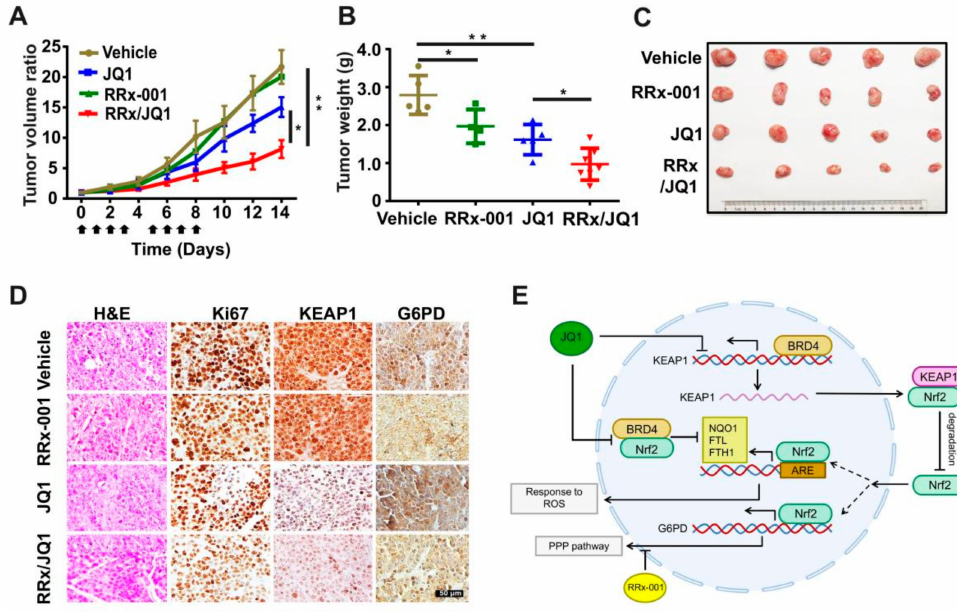
Figure 6. Co-targeting BRD4 and G6PD suppresses SCLC in vivo. ( A ) Tumor volume curves of H82 xenograft mice treated with RRx-001, JQ1, or a combination of RRx-001 and JQ1. The arrow represents the time of drug injection. ( B ) Tumor weights of H82 xenograft mice after 14 days of drug treatment. ( C ) Imaging of representative tumors excised at each group’s end of the experiment. ( D ) Representative immunohistochemistry images of Ki67, KEAP1, and G6PD on each group. Scale bar, 50 µ m. ( E ) Model for targeting the BRD4-KEAP1-Nrf2-G6PD axis in SCLC cells. RRx, RRx-001. * p < 0.05; ** p < 0.01 (Student’s t